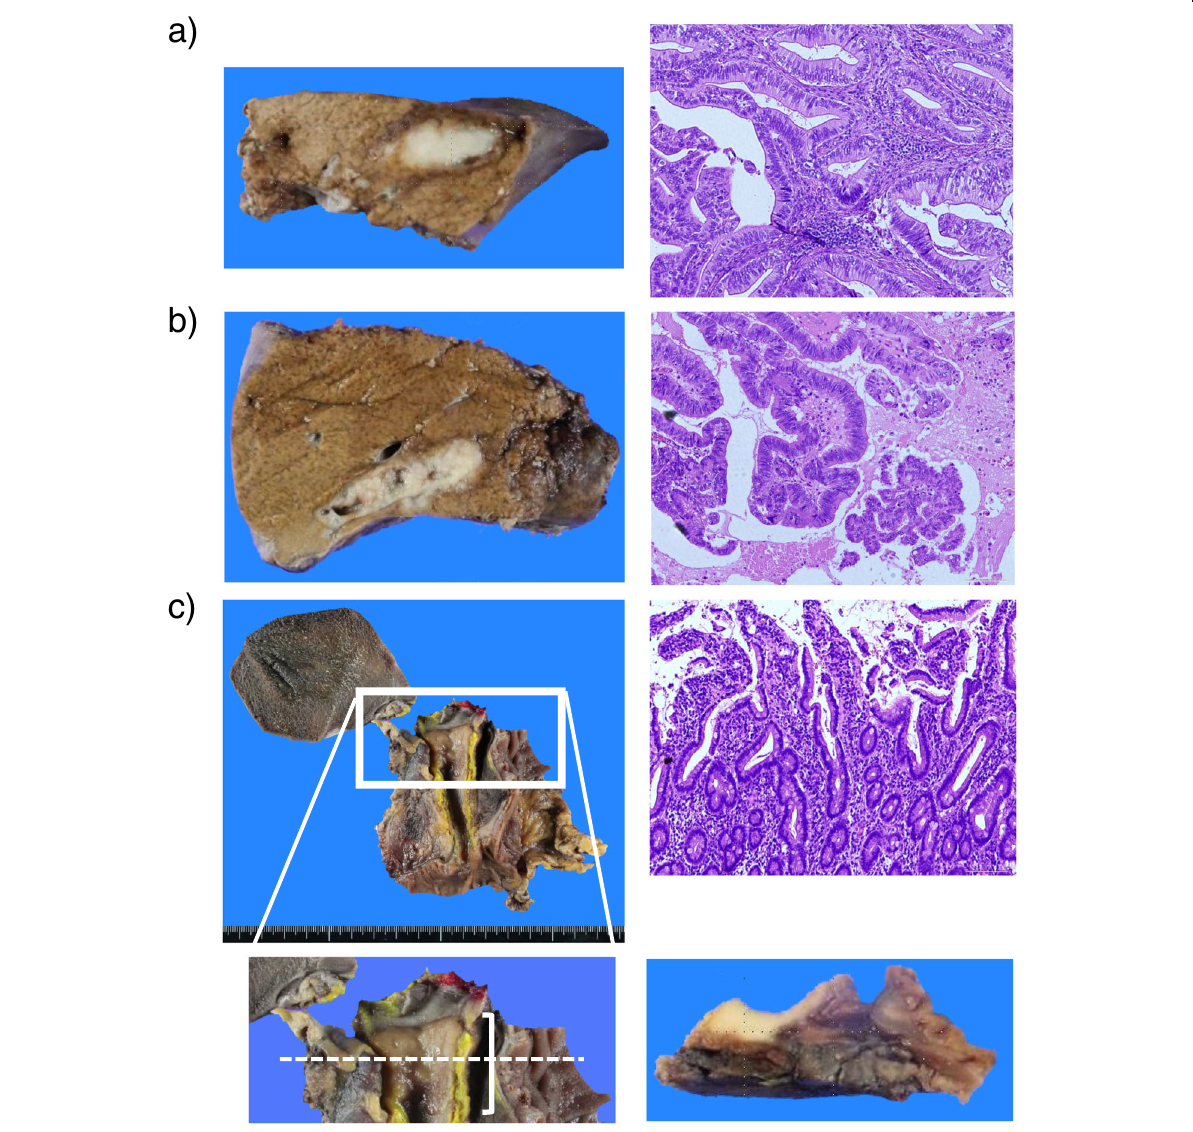
Fig. 3 Pathological findings of the intrahepatic and extrahepatic bile duct tumors. a Intrahepatic cholangiocarcinoma with well-differentiated adenocarcinoma, 1.9 cm (segment III), macroscopic image (left panel) and microscopic image (right panel). b Intrahepatic cholangiocarcinoma with well-differentiated adenocarcinoma, 2.8 cm (segment VI), macroscopic image (left panel) and microscopic image (right panel). c Distal cholangiocarcinoma with well-differentiated adenocarcinoma, macroscopic image (upper left panel), microscopic image (upper right panel), image magnification (lower left panel). The bracket indicates the range of extrahepatic bile duct tumor, cross-sectional image at the dot line (lower right